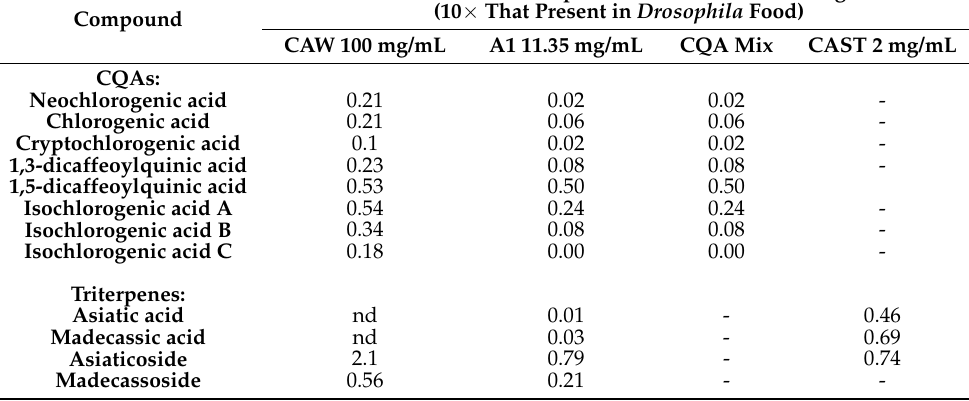
Table 1. Concentration of caffeoylquinic acids (CQAs) and triterpenes (TT) in Centella asiatica water extract (CAW), CAW subfraction A1, CQA mix and CAST TM . Fractionation of CAW using the scheme described in Section 2.2.3 resulted in a fraction (A1) where the CQAs and triterpene glycosides had been concentrated (on a % w / w ) basis compared to their content in CAW. This is due to the removal of a large proportion of methanol insoluble (very polar) and dichloromethane (non-polar) components of CAW in earlier fractionation steps. nd = not detected. Concentration of Compounds in Test Solutions (mg/mL) (10 × That Present in Drosophila Food) Compound CAW 100